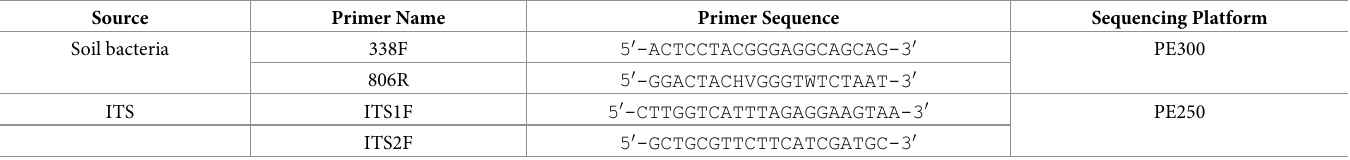
Table 1. Sequencing type and primer